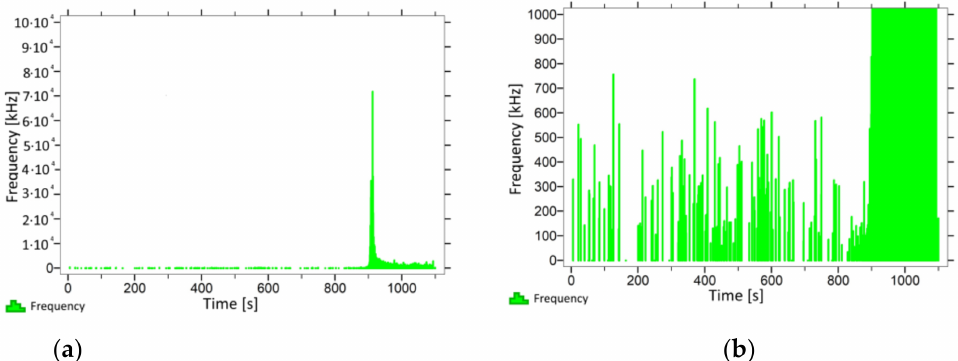
Figure 2. Graph of frequency distribution during the test for a representative sample from series P 1 : ( a ) considering the entire occurring frequency range and ( b ) with details about the frequency range before the moment of